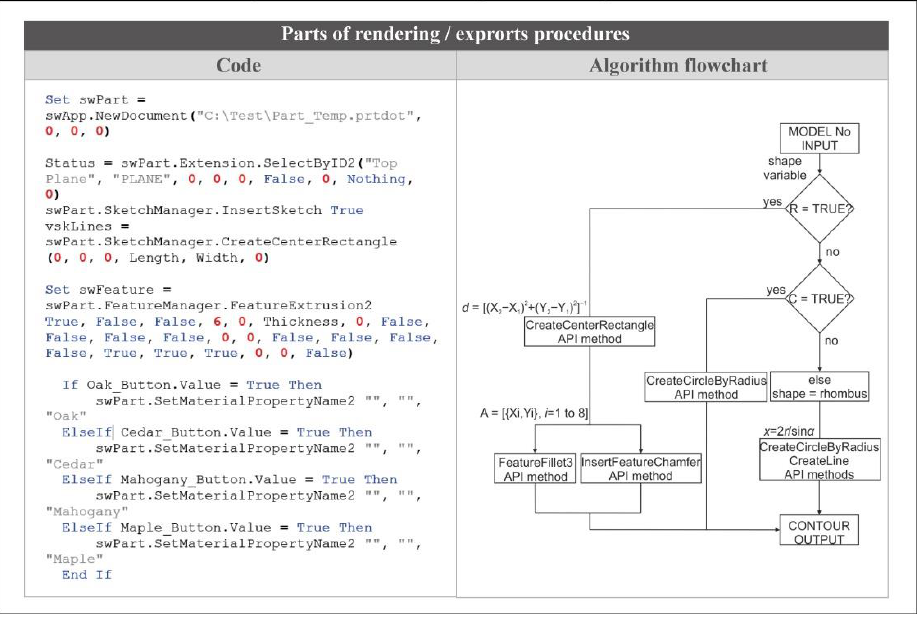
Figure 7. Code sample and algorithm flowchart used.